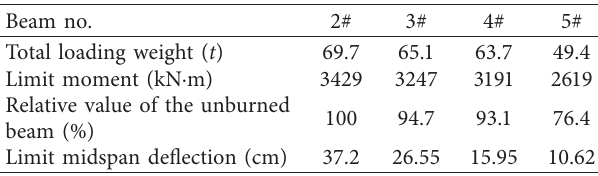
Table 6: Limit loading displacement results.